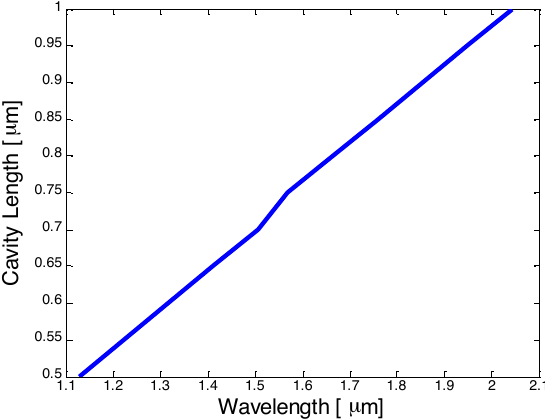
Fig.9. Schematic diagram to changing the electric field in the cavity of the plasmonic